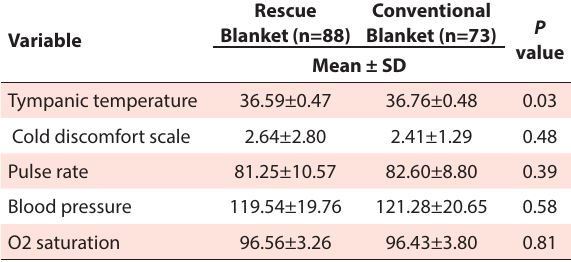
Table 2. Variables evaluated at the time of patient arrival in the ED of the destination